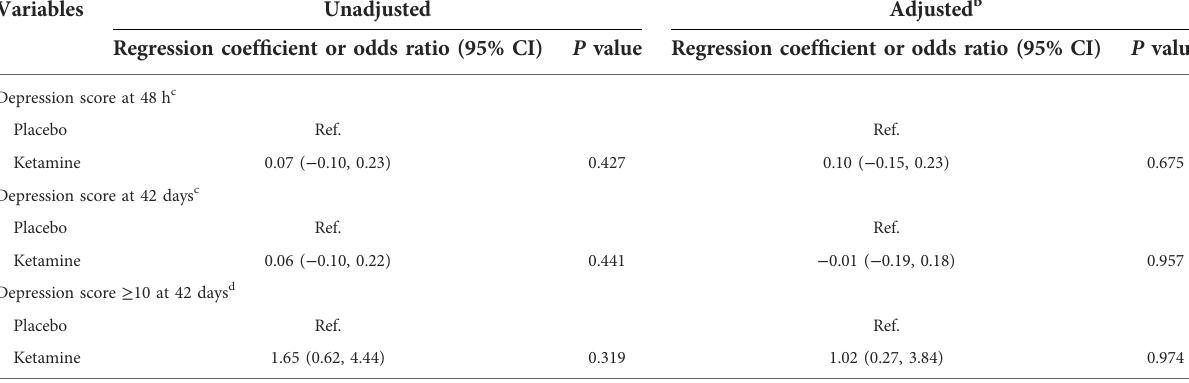
TABLE 4 Association between ketamine use and depression scores or depressive score ≥ 10 after caesarean delivery a .